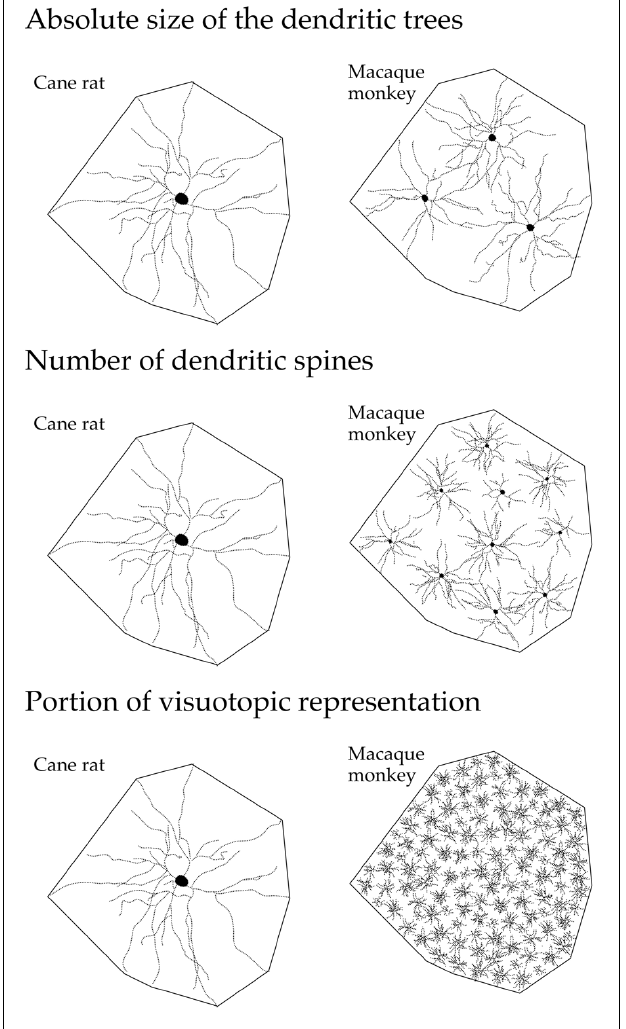
FIGURE 15 | Neuron structure and cortical connectivity. Schematic, not drawn to scale, illustrating the dendritic tree of the “average” layer III pyramidal cell in V1 of the adult cane rat and macaque monkey: that in the cane rat is, on average, three times the size of that in the macaque monkey. Differences in the size, branching structure and spine density result in a more than 10-fold difference in the estimate of the total number of spines, putative excitatory inputs, in the basal dendritic tree of the “average” layer III pyramidal cell between the two species. As V1 in the adult macaque is, on average, more than 40 times the size of V1 in the adult cane rat, the dendritic trees of cells in the adult cane rat sample a portion of the visuotopic field approximately 120 times larger than do those in the adult monkey. Thus, 120 cells are required in the macaque monkey V1 to achieve the spatial coverage of a single cell in the cane rat. One hundred and twenty cells in the adult macaque V1 have, on average, a sum total of more than 88,000 spines (120 × 743), being more than 110 times the number of spines in an individual cell in the adult cane rat. (reproduced from Elston and Manger,